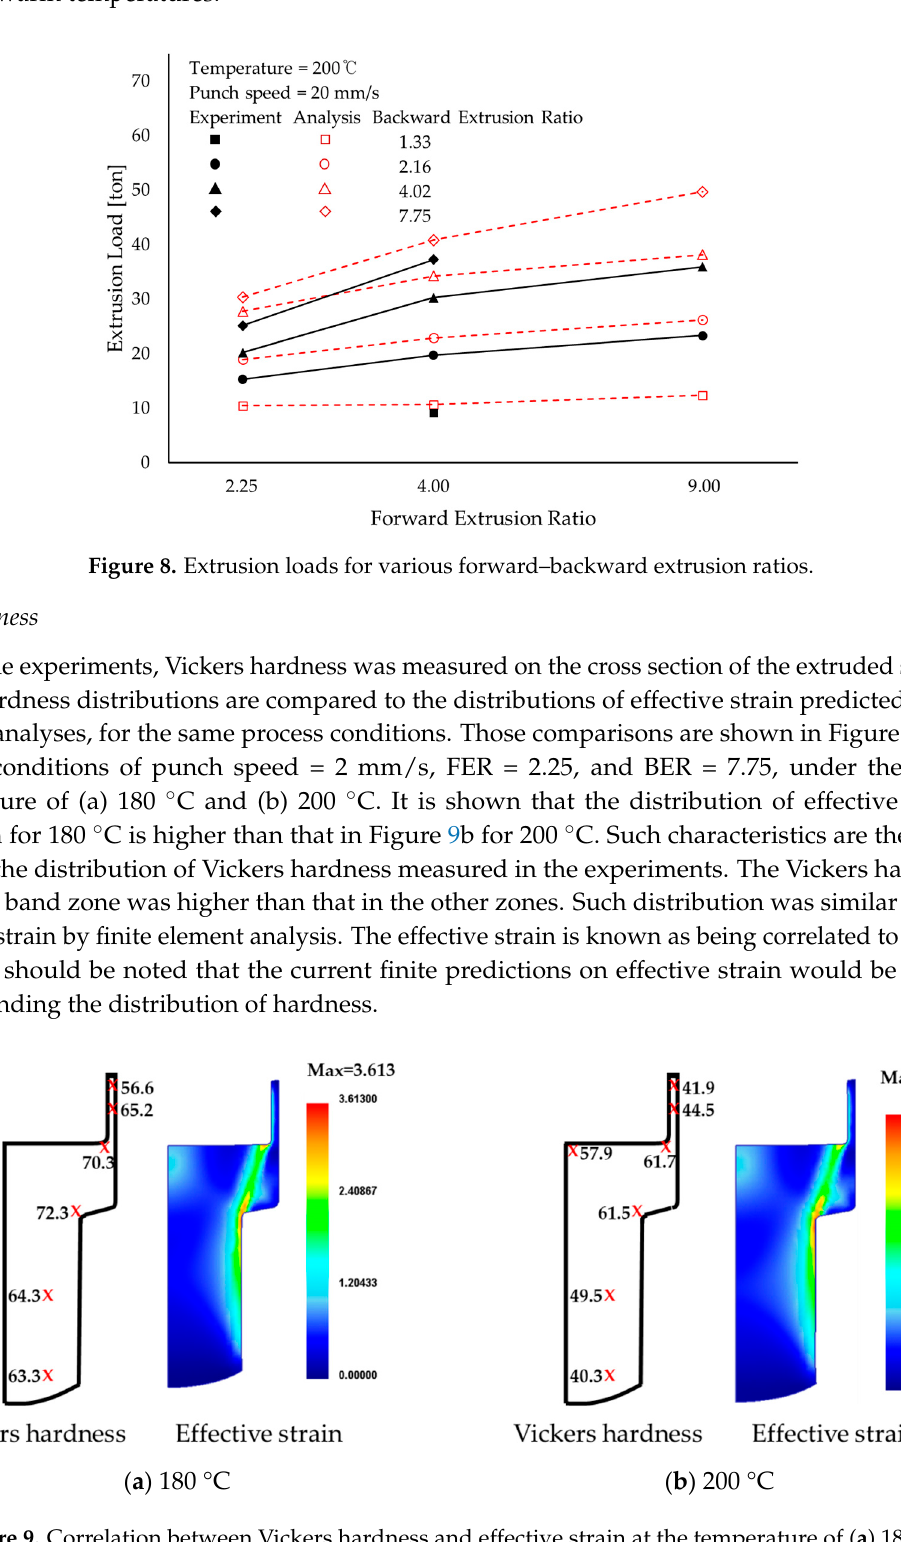
Figure 9. Correlation between Vickers hardness and effective strain at the temperature of ( a ) 180 °C, ( b ) 200 °C. (Punch speed = 2 mm/s, FER = 4.0, BER = 4.02).